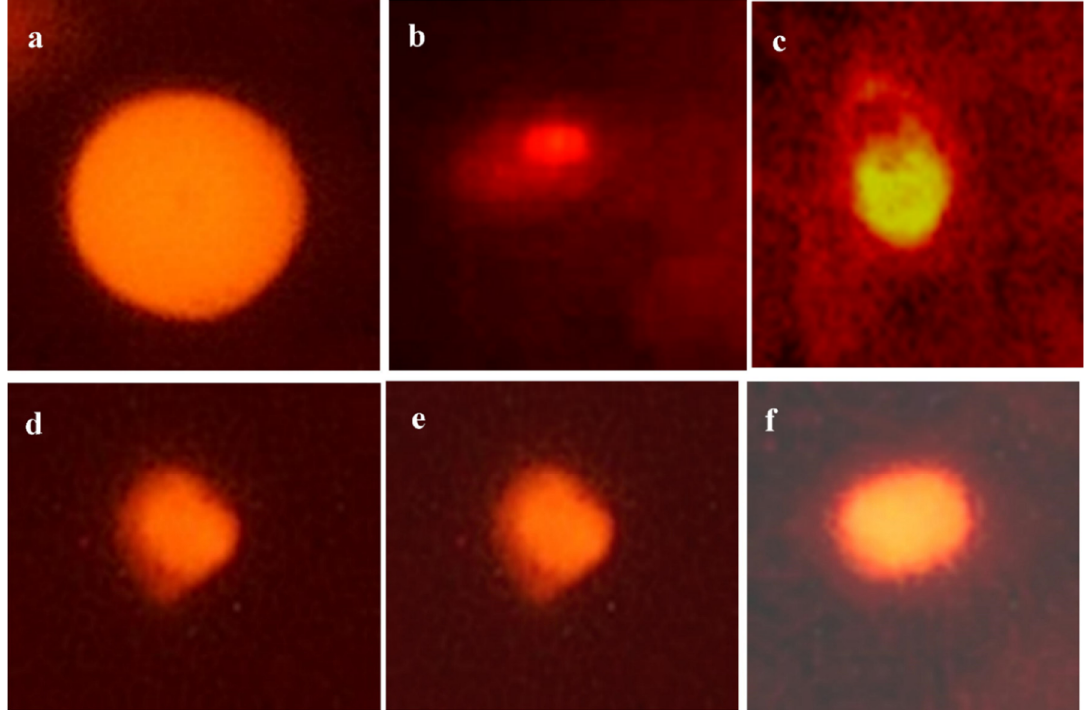
Table 8. Effect of single or combined supplementation of vitamin C and E on the DNA degradation indices in broiler chickens at the end of the 6th week (Mean ± SD).